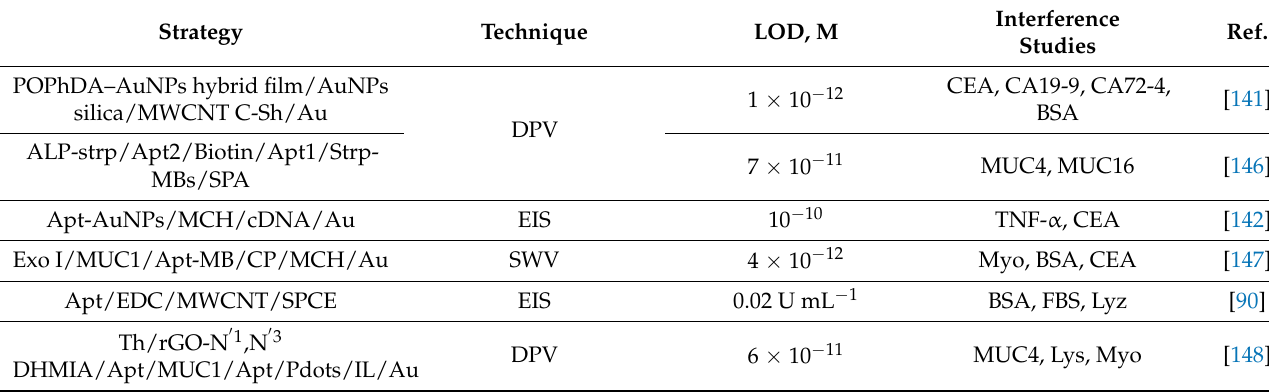
Table 2. Analytical performance of selected electrochemical aptasensors for MUC1 detection. Strategy Technique LOD, M